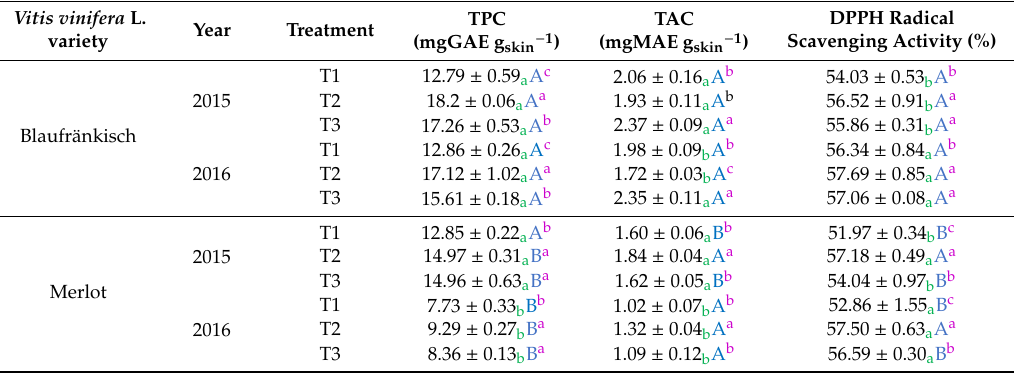
Di ff erent green subscript lower case letters in each row indicate statistically significant di ff erences ( p < 0.001) between years for the same variety and same treatment. Di ff erent blue upper case letters in each row indicate statistically significant di ff erences ( p < 0.001) between two varieties for the same year and same treatment. Di ff erent magenta superscript lower case letters in each row indicate statistically significant di ff erences ( p < 0.001) between treatments for the same variety and same